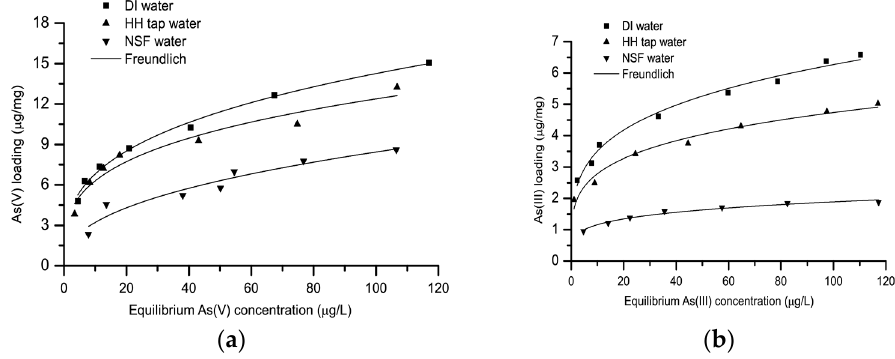
Figure 3. ( a ) As(V) and ( b ) As(III) adsorption isotherms for DFH using three different water matrixes. Solid lines represent the Freundlich model by using non-linear fitting. Experimental conditions: Initial (As(V)) 190 µg/L, initial (As(III)) 190 µg/L, equilibrium pH value 7.9 ± 0.1 and temperature 20 °C.